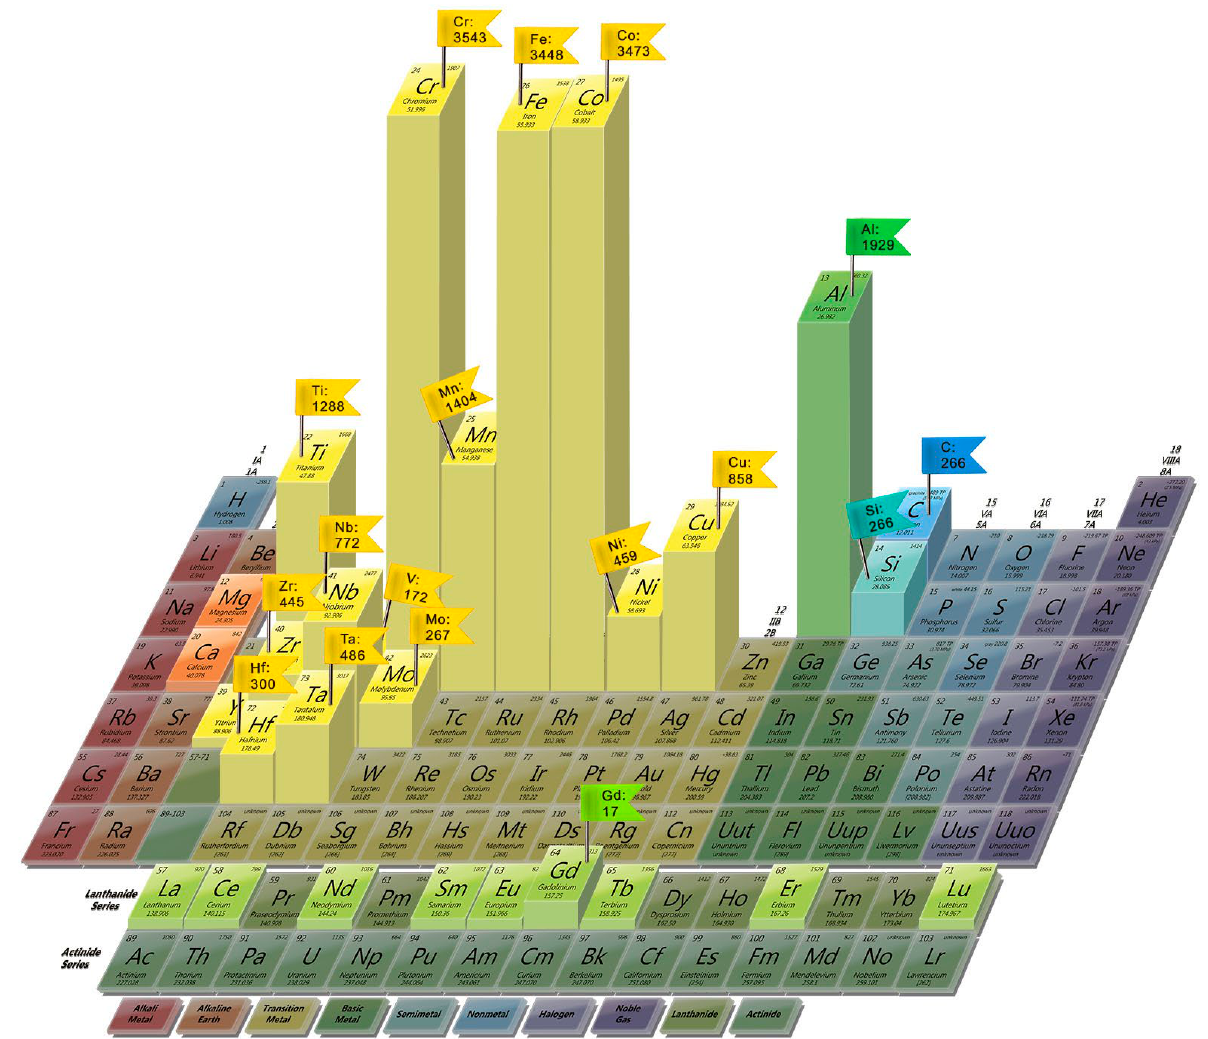
Figure 2. Frequency of use of elements in HEAs, Scopus data from years 2010–2022 (shown as vertical lines with corresponding numbers, elements used less than 10 times shown without numbers).